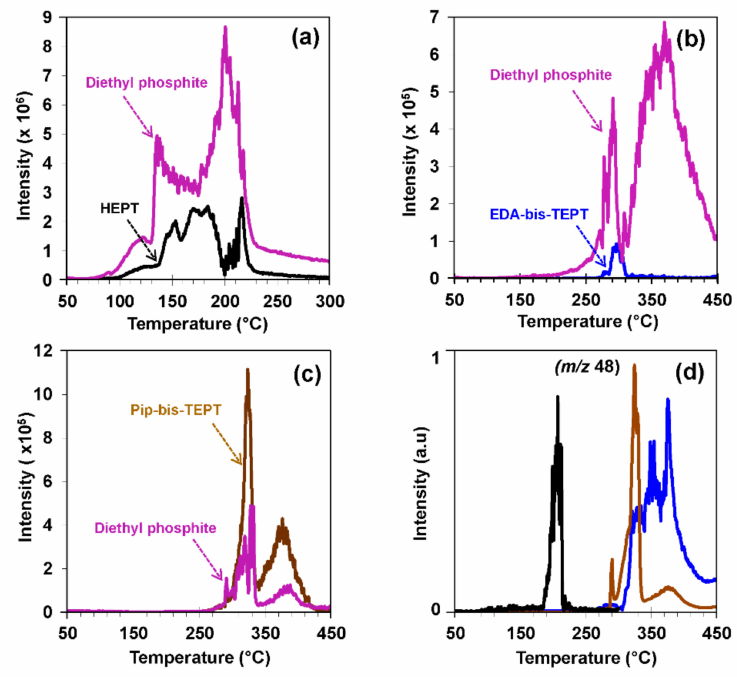
Figure 4. Extracted ion chromatogram of the synthesized compounds in comparison to their release of diethyl phosphite ( a – c ) and production of HPO ( m / z 48) ( d